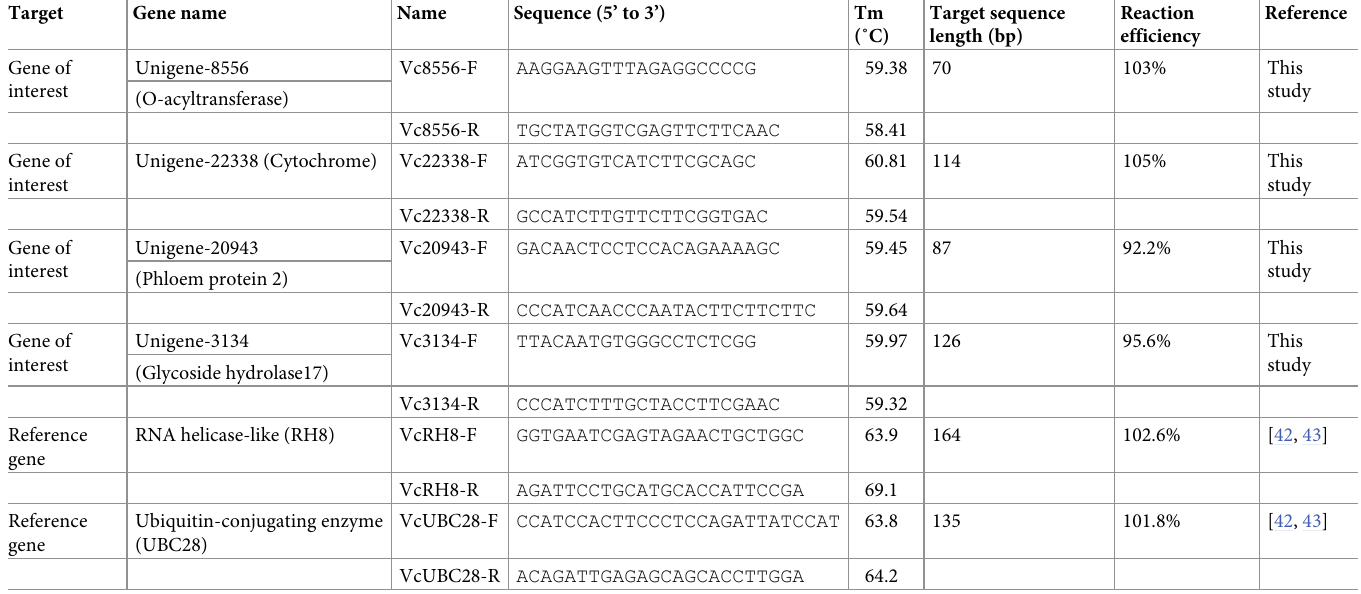
Table 1. Primer sequences for the four unigenes and two reference genes used for qRT-PCR validation, including primer melting temperatures (T m ), and reaction efficiencies